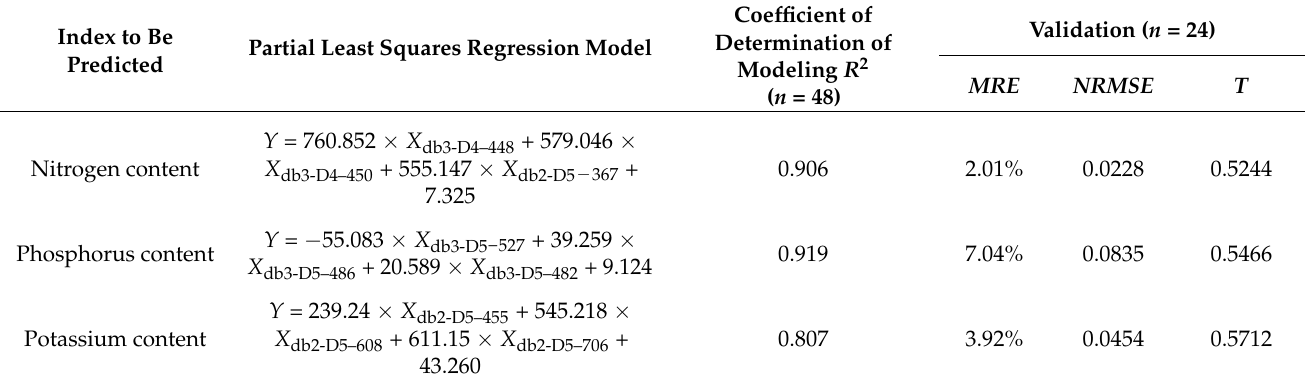
Table 4. Results of the partial least squares diagnostic model for nitrogen, phosphorus and potassium contents of sweet corn based on binary wavelet sensitivity coefficient.